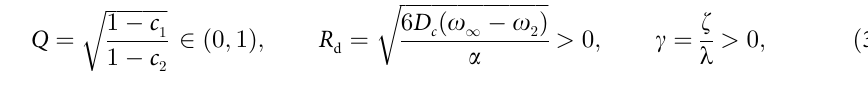
ffiffiffiffiffiffiffiffiffiffiffiffi 1 (cid:0) c